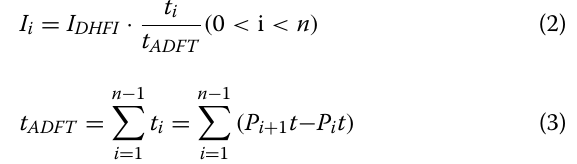
Calculation model of feed